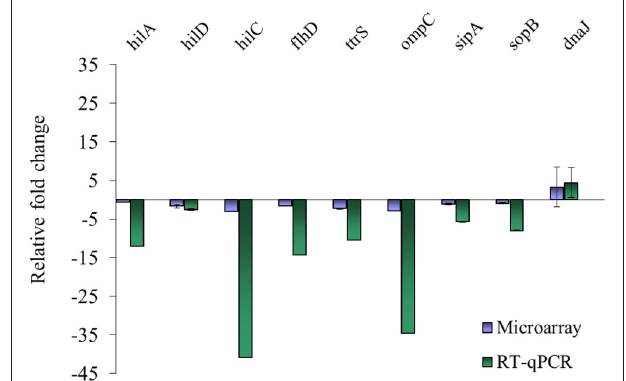
FIGURE 1 | Comparison of microarray and RT-qPCR data on select genes after exposure of S . Enteritidis PT8 to SICs of TC. Data are from three replicates.